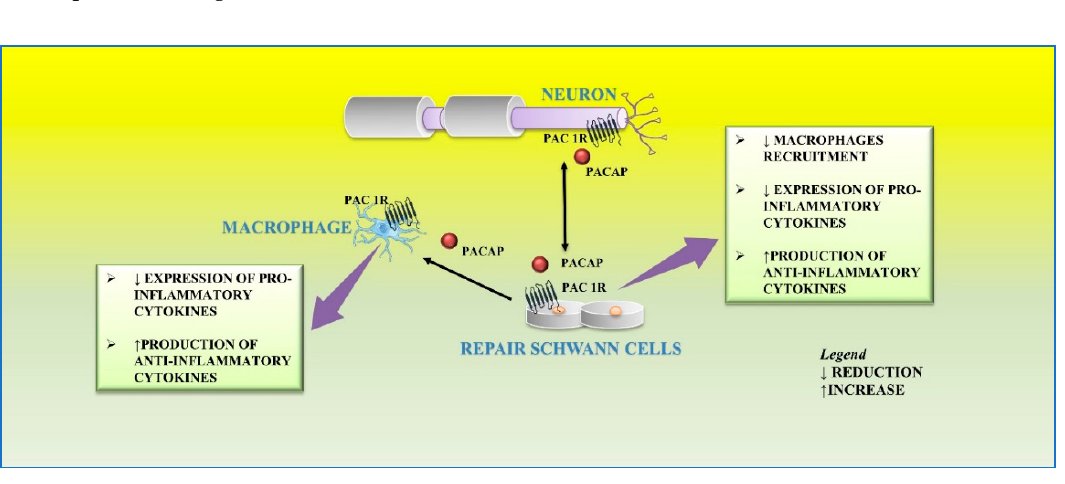
Figure 4. Autocrine and/or paracrine action of PACAP on inflammatory response and myelinization of peripheral nerve following injury.